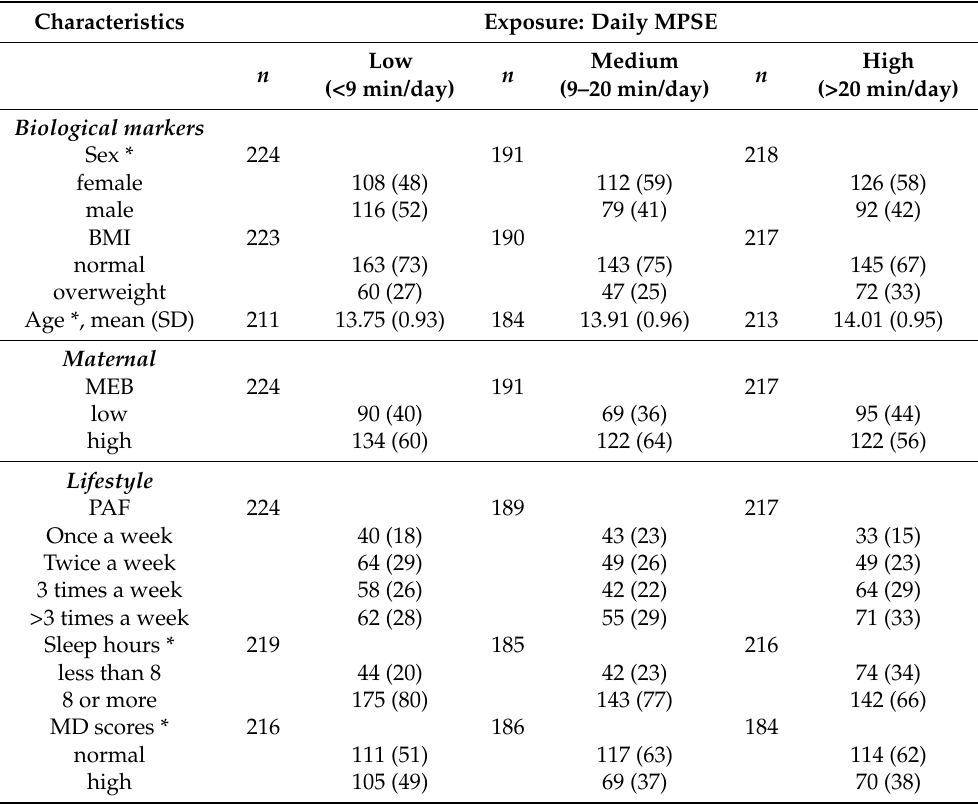
Table 1. Baseline characteristics of the study population by exposure group and the relation between each covariate and the main exposure ( n = 632).